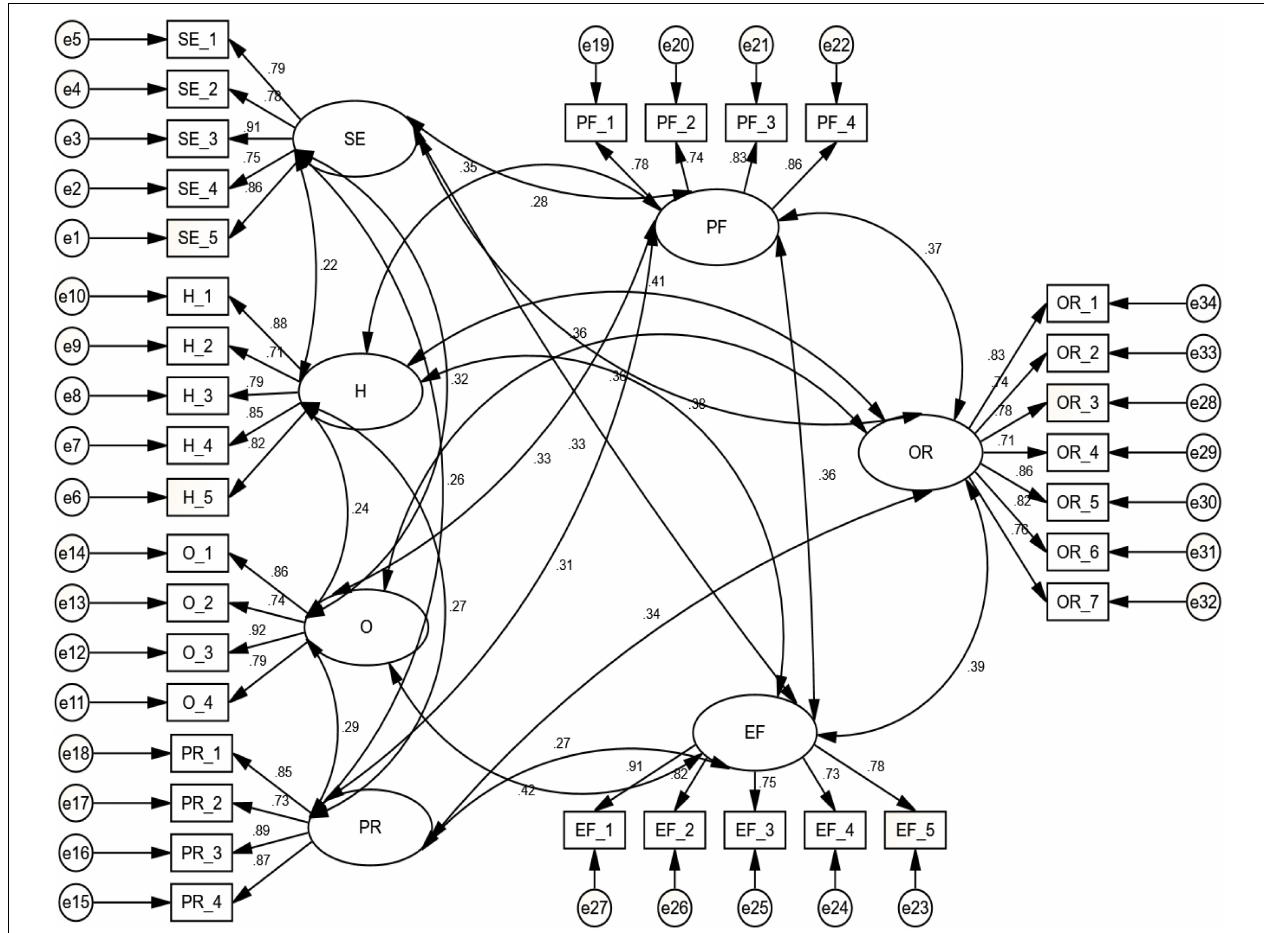
FIGURE 2 | Measurement